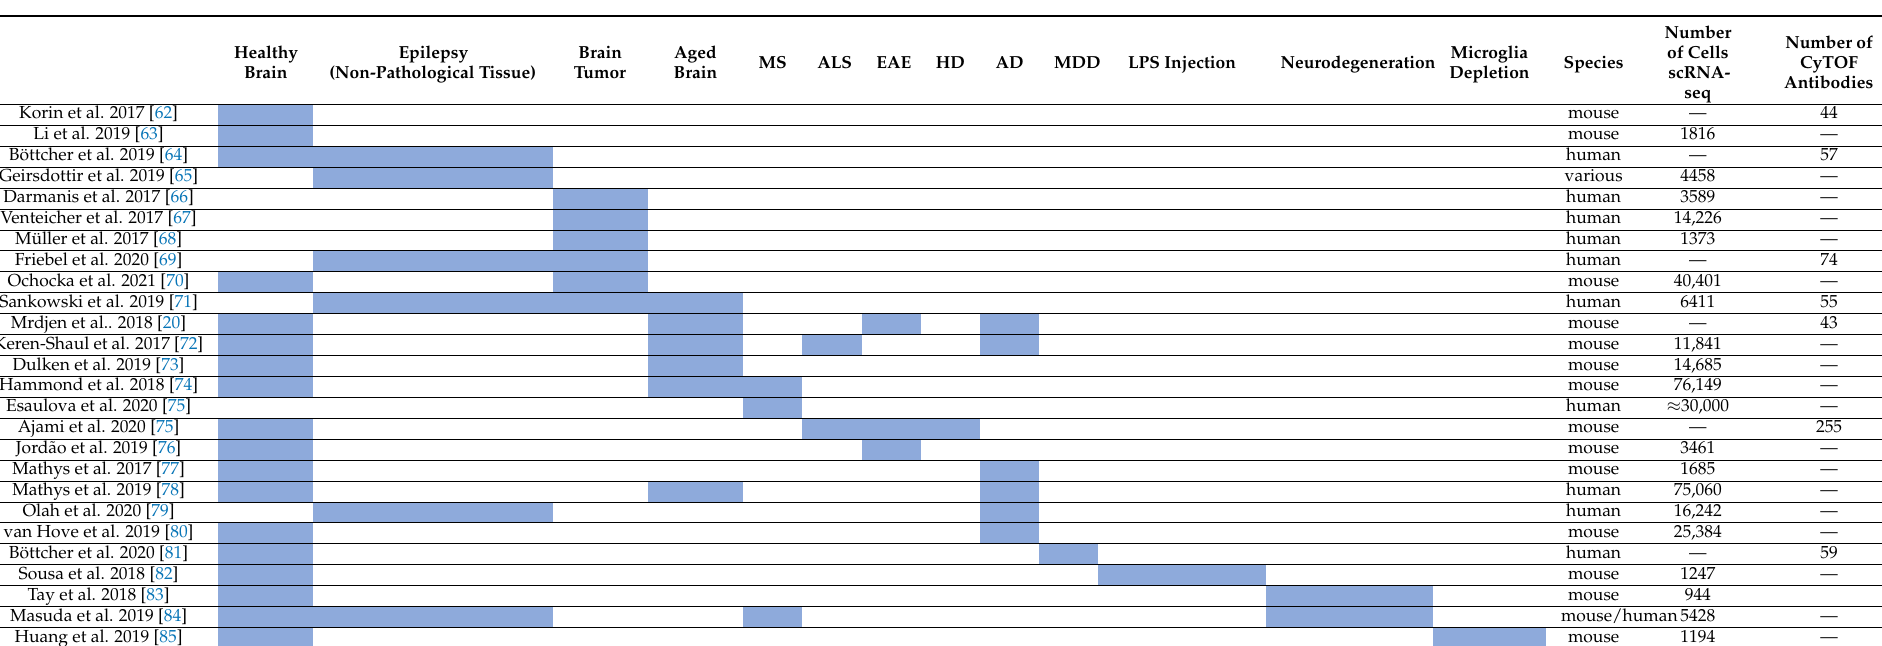
Table 1. Summary of single-cell omics studies on the immune system cells in the brain including microglia. Blue squares indicate that study included cells from a given condition. MS—multiple sclerosis, ALS—amyotrophic lateral sclerosis, EAE—experimental autoimmune encephalitis, HD—Huntington’s disease, AD—Alzheimer’s disease, MDD—major depressive